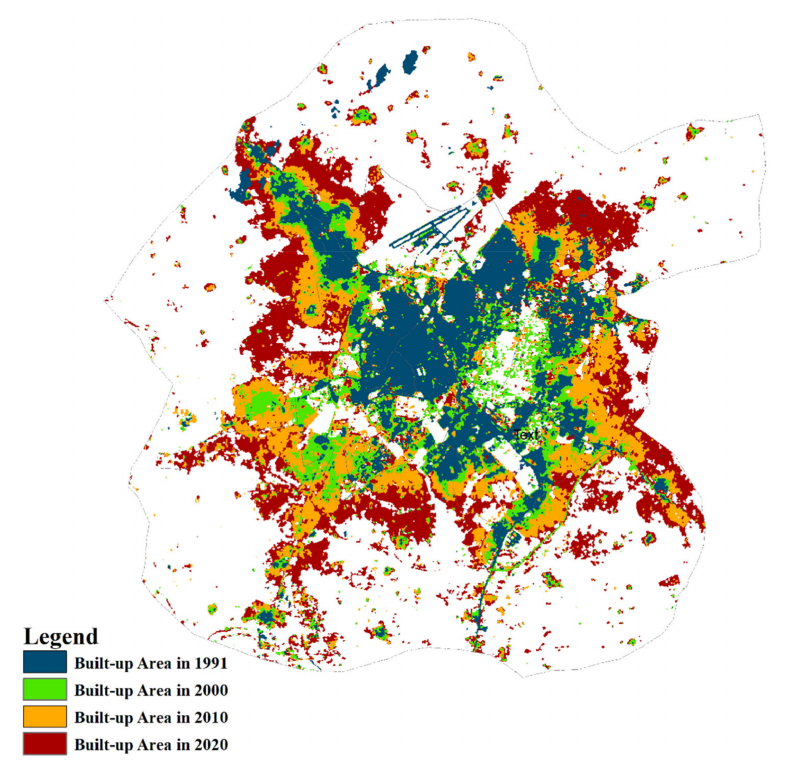
Figure 8. Urban Expansion of Kano Metropolis, Nigeria.